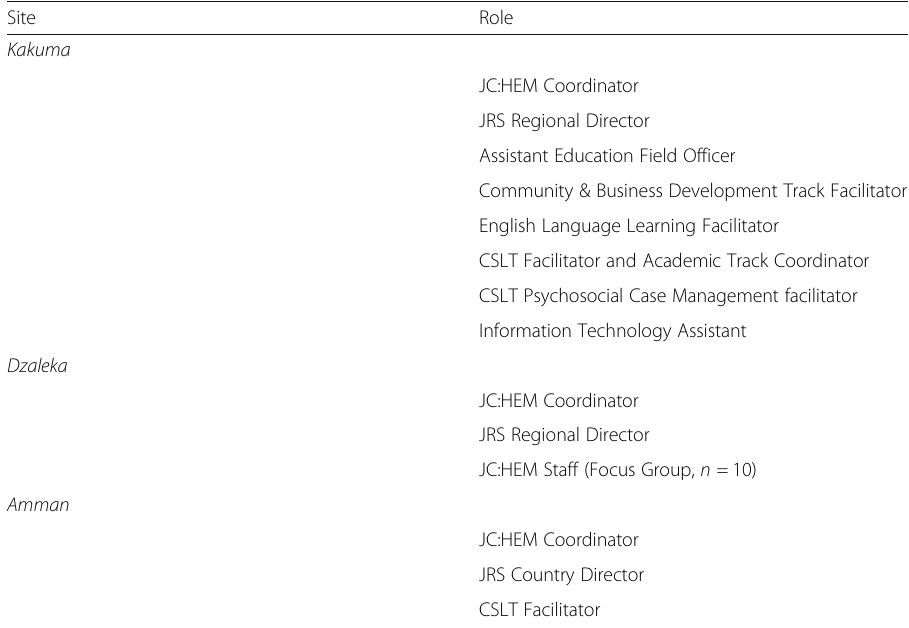
Table 1 List of Onsite Staff Interviewed ( n = 23)